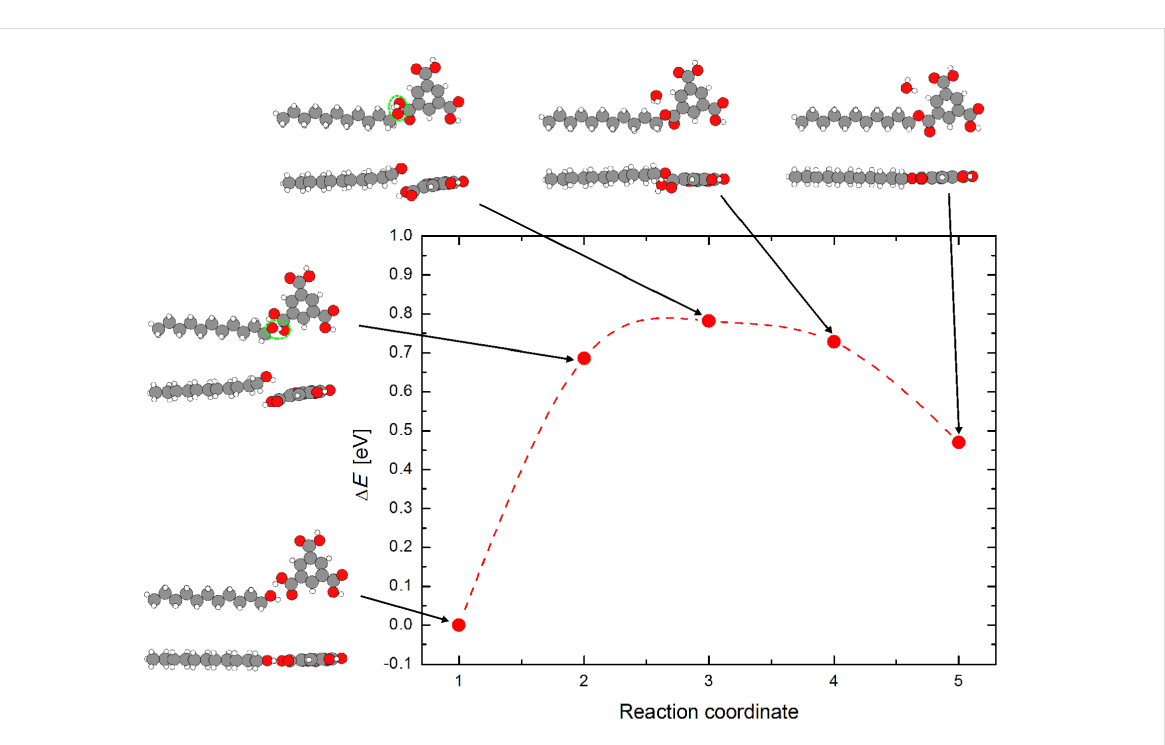
Figure 8: Energy diagram of the reaction path of TMA and undecanol to form TMA–undecyl ester and water for isolated molecules (gas phase) calcu- lated using DFT (PBE). The corresponding geometry of the molecules in the simulation is shown for each energy point marked in the reaction path. The “flat approach” (almost 2-dimensional) as shown in the simulation for the free molecules is strongly supported by the underlying crystal surface in the experiments.